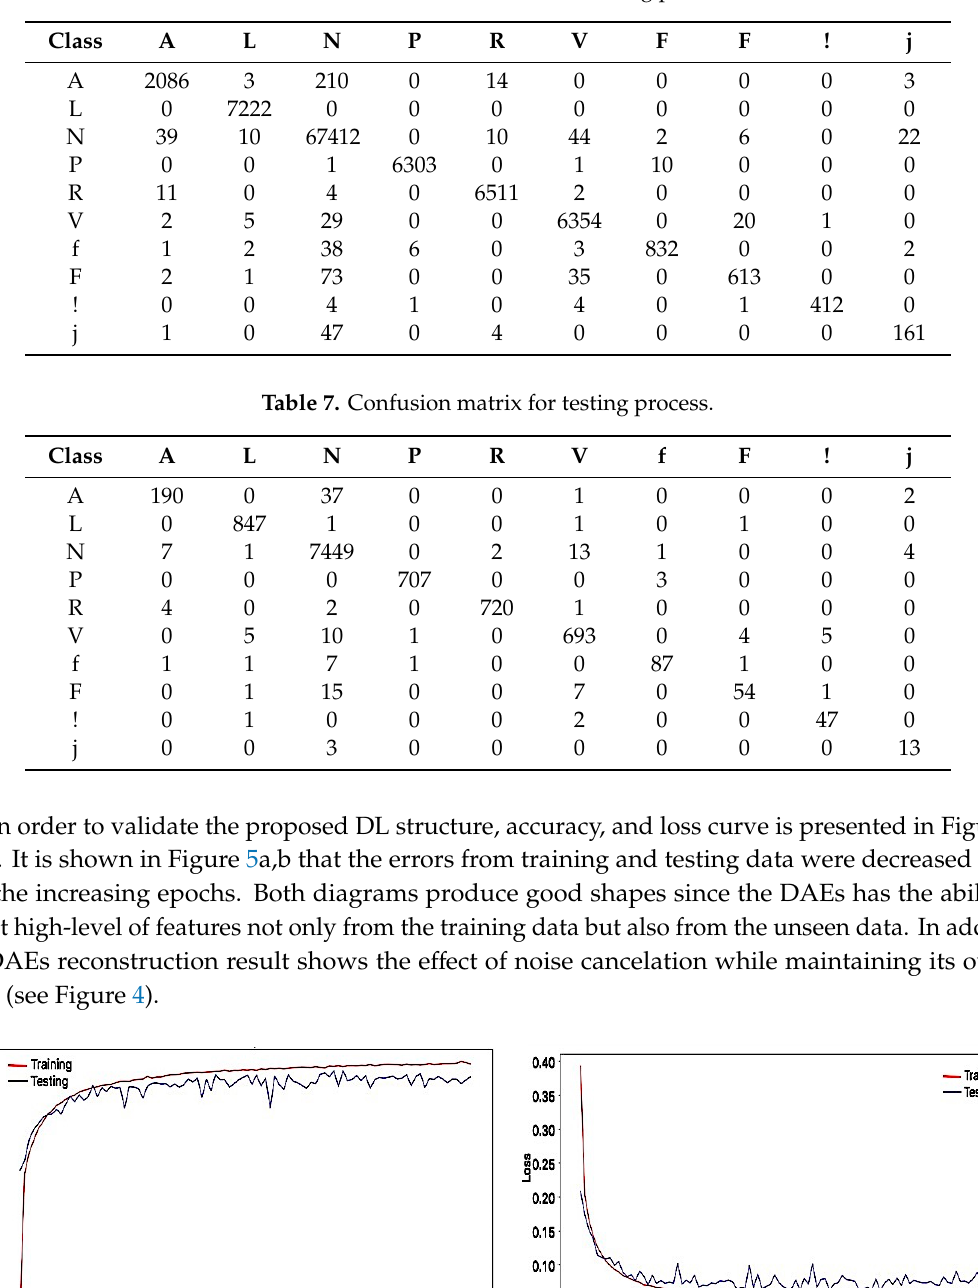
Table 6. Confusion matrix for the training process.